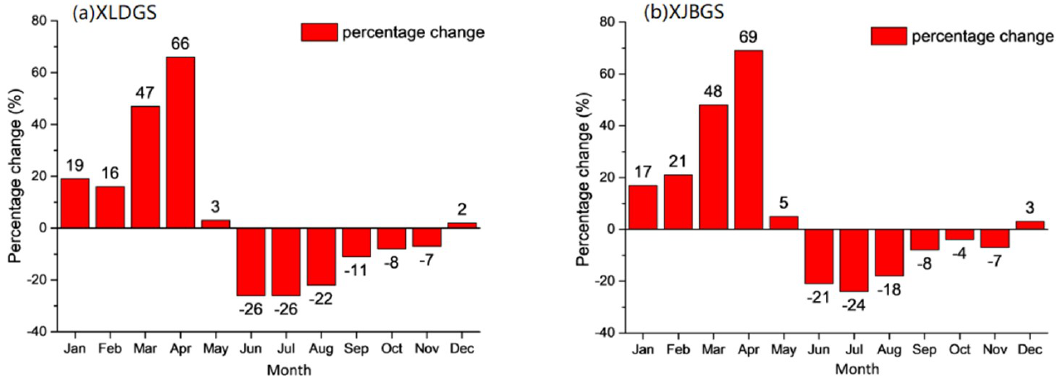
Figure 3. The seasonal distribution of the mean percentage change of discharge at XLDGS ( a ) and XJBGS ( b ) relative to the pre-impoundment period. Percentage change = (monthly mean discharge after impoundment − monthly mean discharge in pre-impoundment period) × 100% / monthly mean discharge in pre-impoundment period.